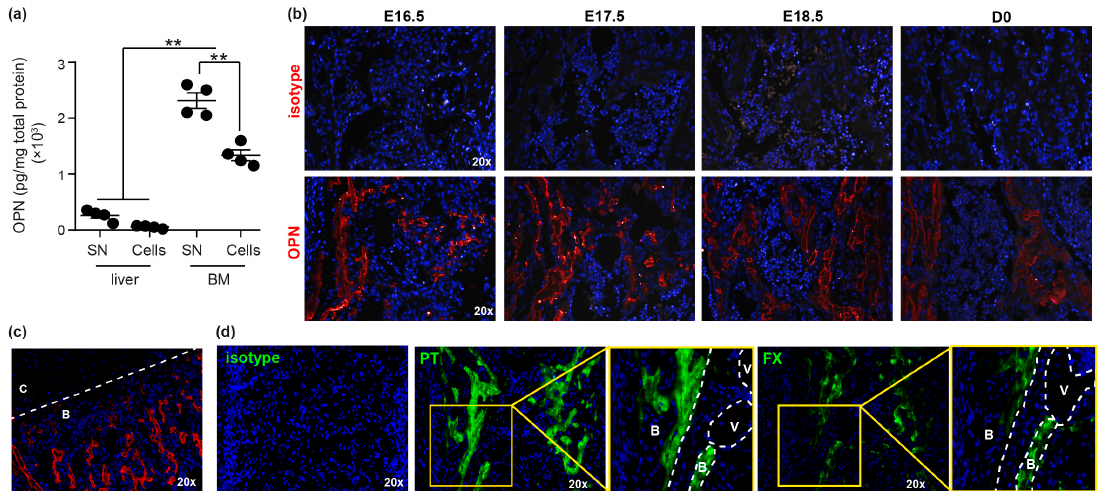
Figure 1. Osteopontin (OPN) is highly expressed in fetal BM. ( a ) OPN protein in E17.5 fetal liver and bone marrow (BM) was quantified using an OPN ELISA (R&D; MOST00). SN: supernatant. ** p < 0.01. ( b ) Immunohistochemical analysis of mouse E16.5, E17.5, E18.5 and D0 BM stained with either isotype control or anti-OPN (red). Grey areas represent autofluorescence. ( c ) E17.5 BM demonstrating lack of OPN expression in growth plate cartilage (C) compared to bone (B). ( d ) Immunohistochemical analysis of mouse E17.5 BM stained with either isotype control or anti-prothrombin (PT) and anti-factor X (FX). White dotted lines delineate the structures of the fetal femurs. B: bone; V: blood vessel; C: cartilage.